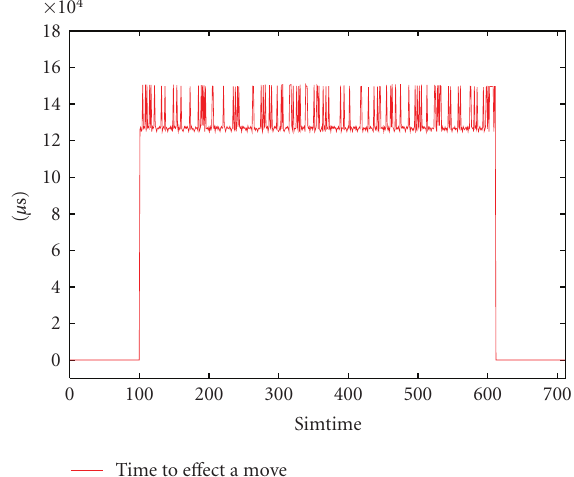
Figure 6: Timeline of the game progress with L = 125 milliseconds and PL =